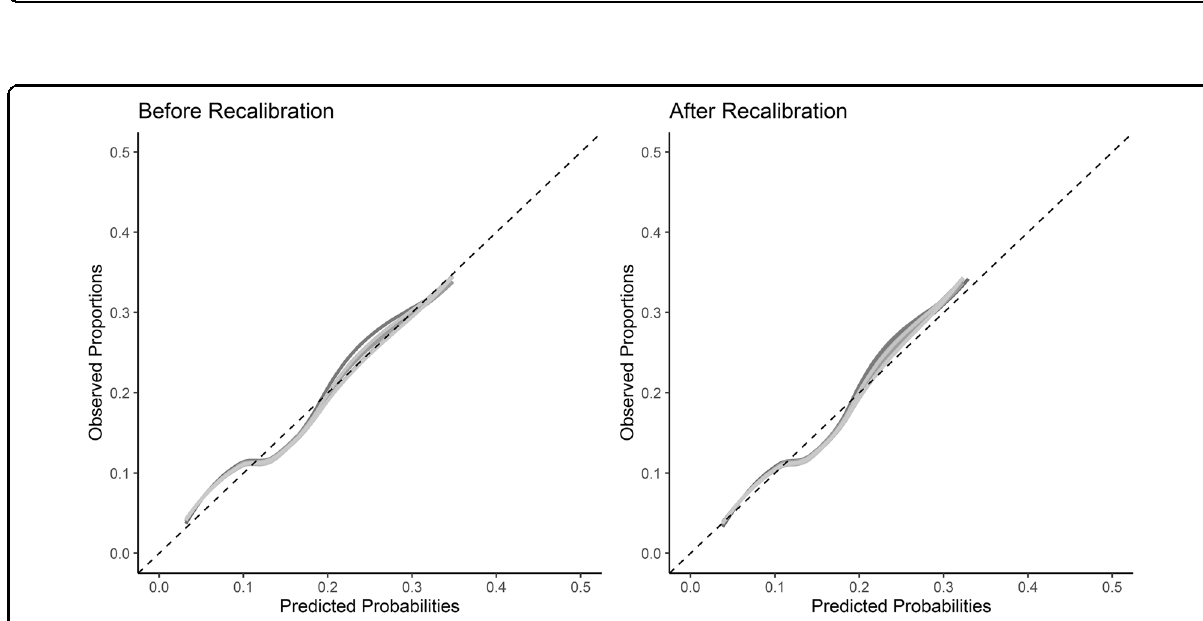
Fig. 1 Calibration plot of development dataset. Fitted lines are the model predicted probabilities categorized into 10 groups for each of the 20 imputed datasets.